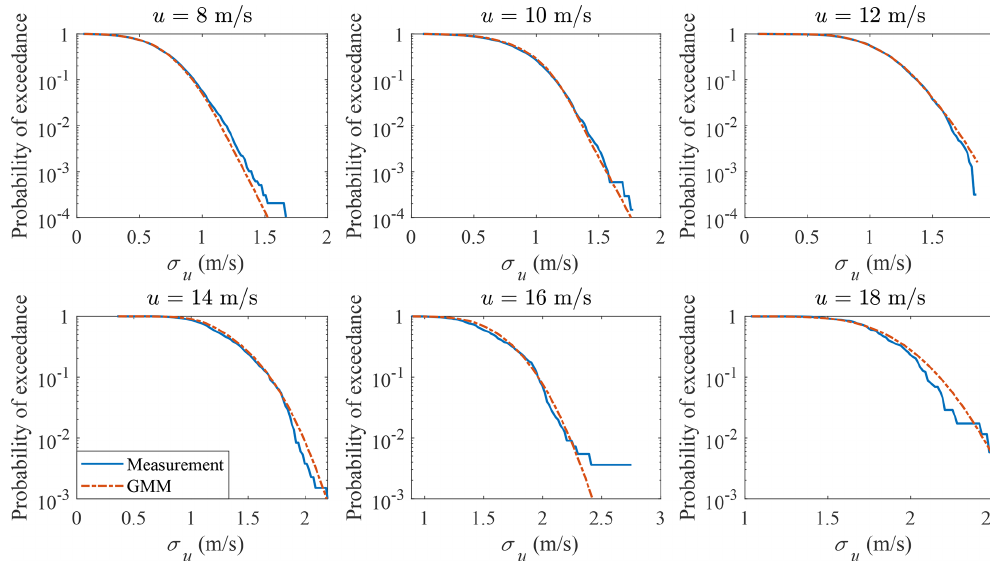
Figure 19. GMM probability of exceedance of σ u conditional on u for the onshore